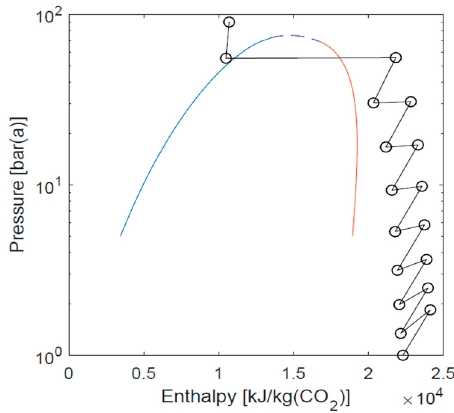
Figure 2. Illustration of a conventional nine-stage compressor in a pressure-enthalpy diagram.